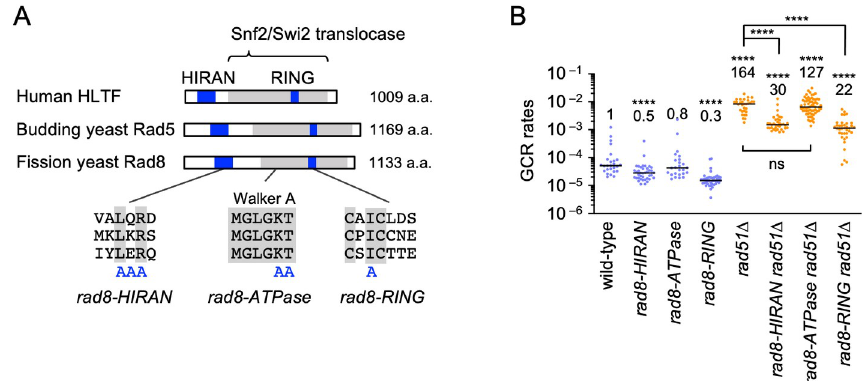
Fig 2. Rad8 HIRAN and RING domains are required for GCRs. (A) A schematic diagram showing the HIRAN, Snf2/Swi2 translocase, and RING finger domains of human HLTF, budding yeast Rad5, and fission yeast Rad8. Amino acid residues substituted for alanine in the rad8-HIRAN , rad8-ATPase , and rad8-RING mutations are indicated. (B) GCR rates of the wild-type, rad8-HIRAN , rad8-ATPase , rad8-RING , rad51 Δ , rad8-HIRAN rad51 Δ , rad8-ATPase rad51 Δ , and rad8-RING rad51 Δ strains (TNF5369, 6205, 6203, 6207, 5411, 6217, 6231, and 6219, respectively). The two-tailed Mann-Whitney test. Non-significant (ns) P > 0.05; ���� P < 0.0001. Numerical source data underlying the graph shown in (B) are provided in Table C in S1